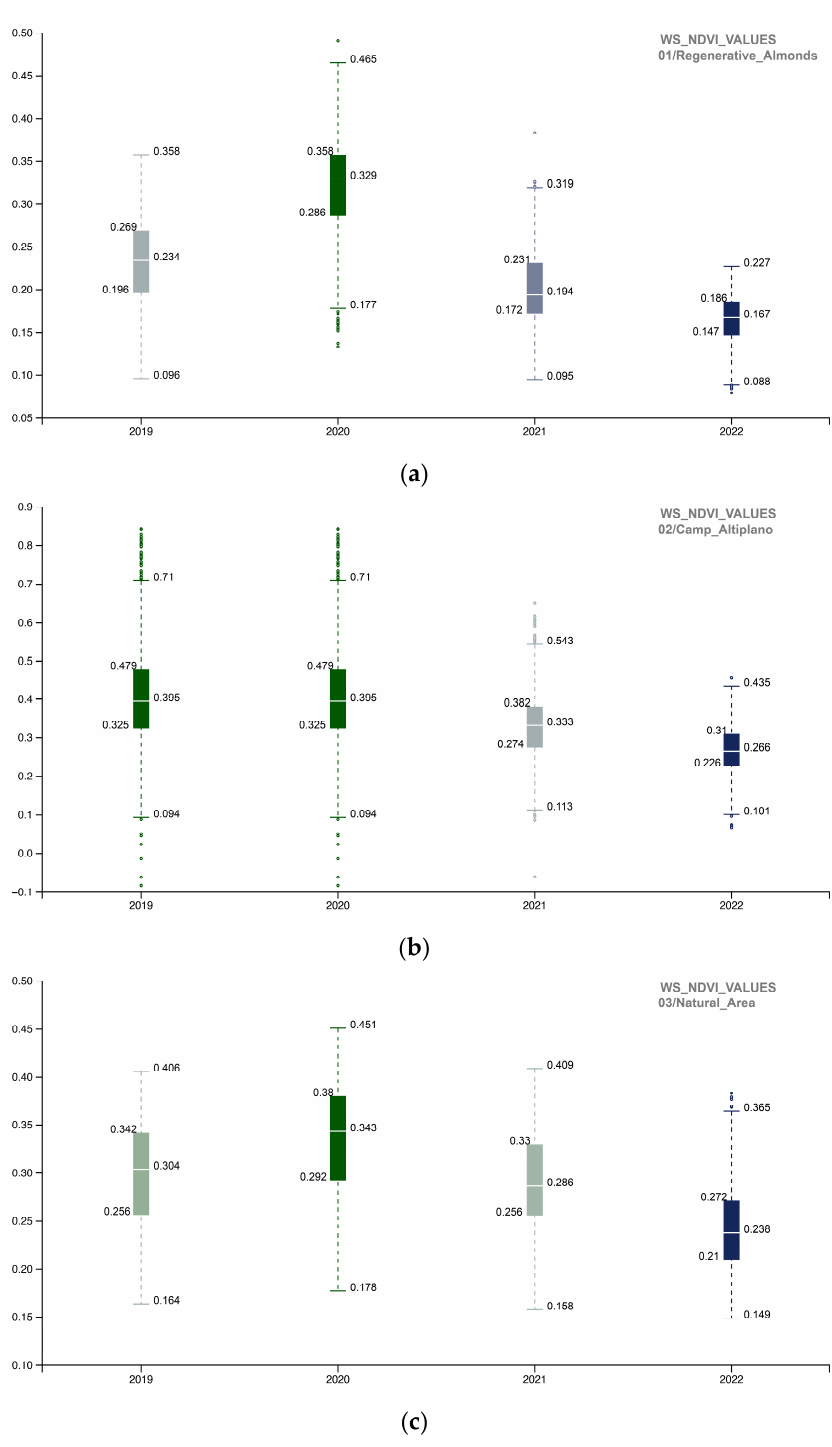
Figure 14. The boxplot summarizes NDVI WS quantitative distribution for each portion of the